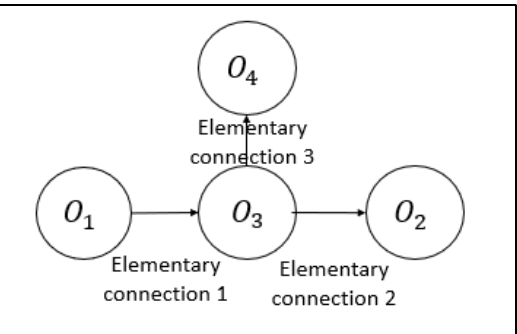
Figure 1. Example of the structure of a connection as a network of elementary connections (O: mathematical object).